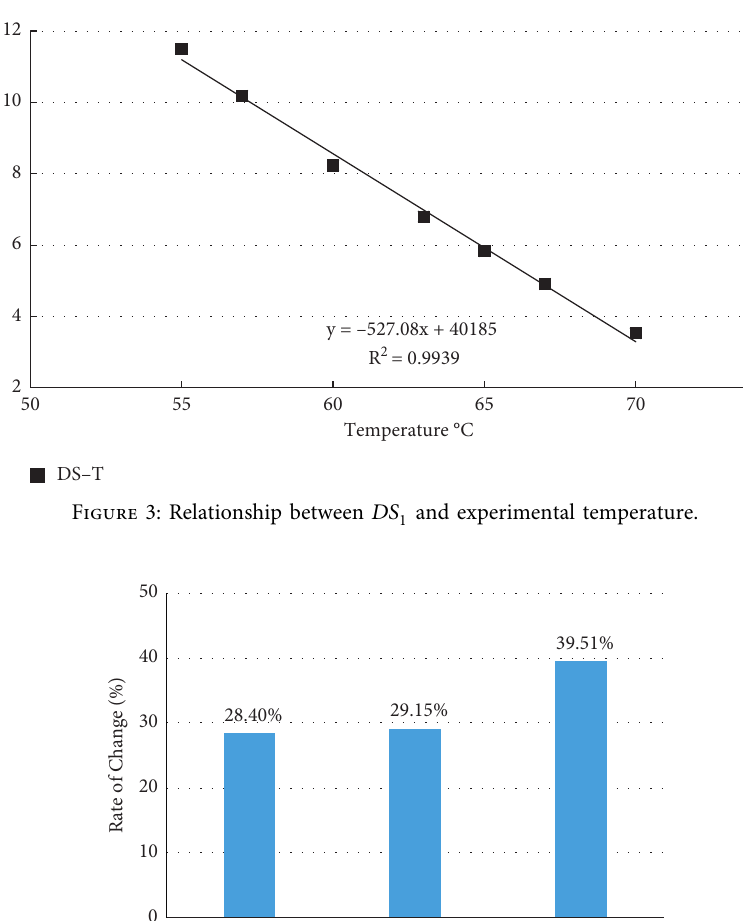
caused by the increase in temperature. 1